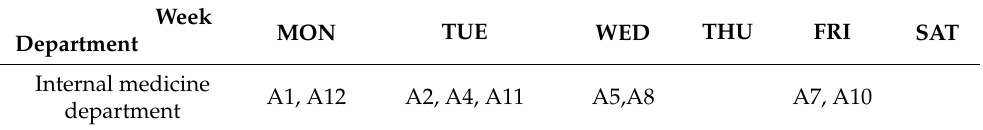
Table 2. Physicians’ surgery